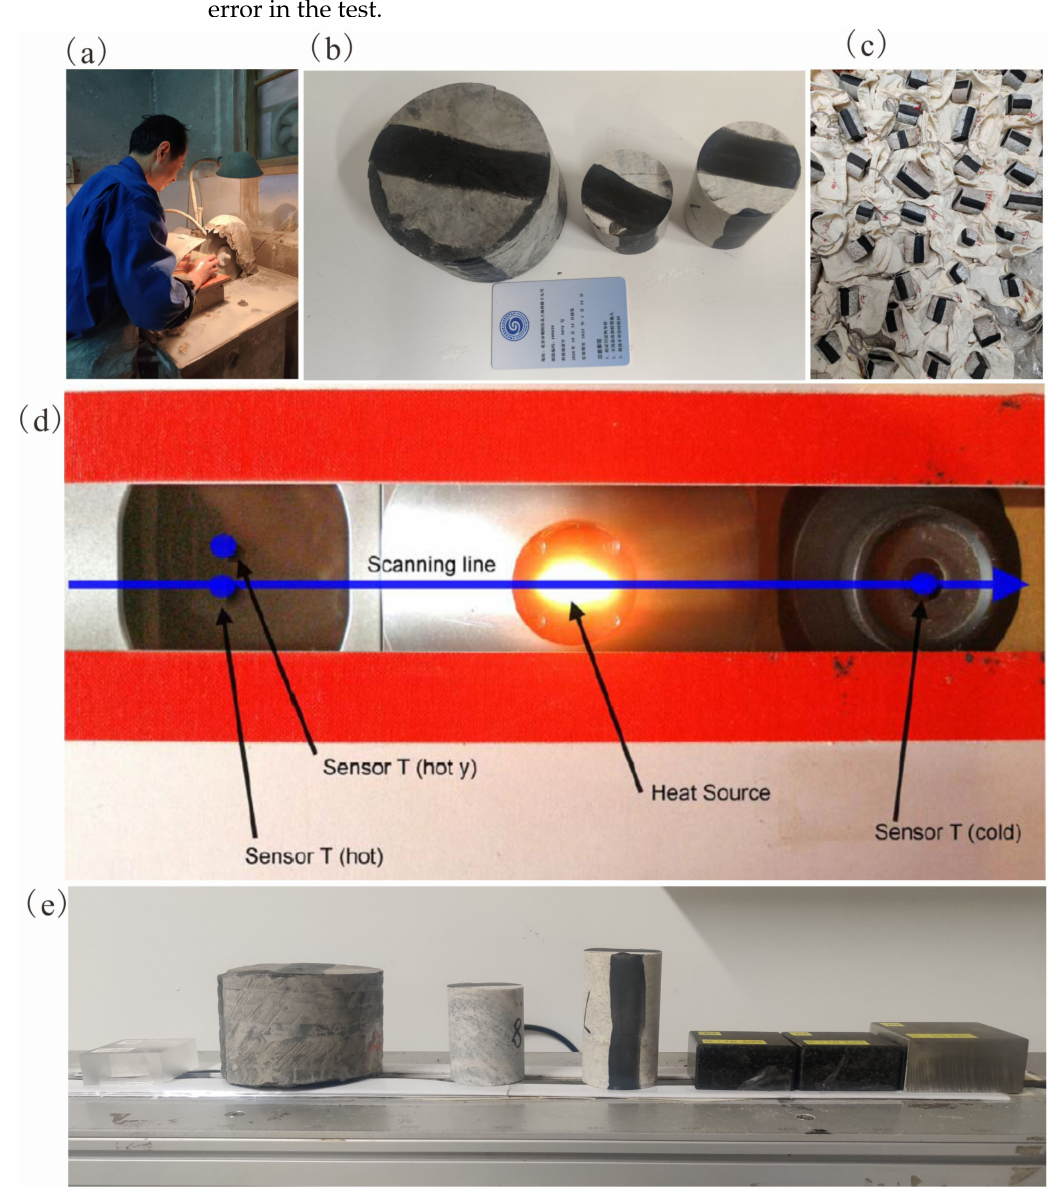
Figure 2. Preparation and TCS measurement of core samples. ( a ) Flattening of the cylinder top and bottom surface; ( b ) painting of the test surface; ( c ) drying; ( d ) thermal conductivity scanner with 2-channel “hot” sensor and 1-channel “cold” sensor; ( e ) the flat platform of TCS, where standards and samples were